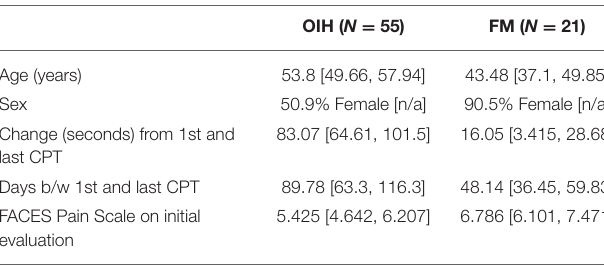
TABLE 1 | Averages in demographics, change in CPT, and FACES Pain Scale for OIH and FM patients, with 95% confidence interval in